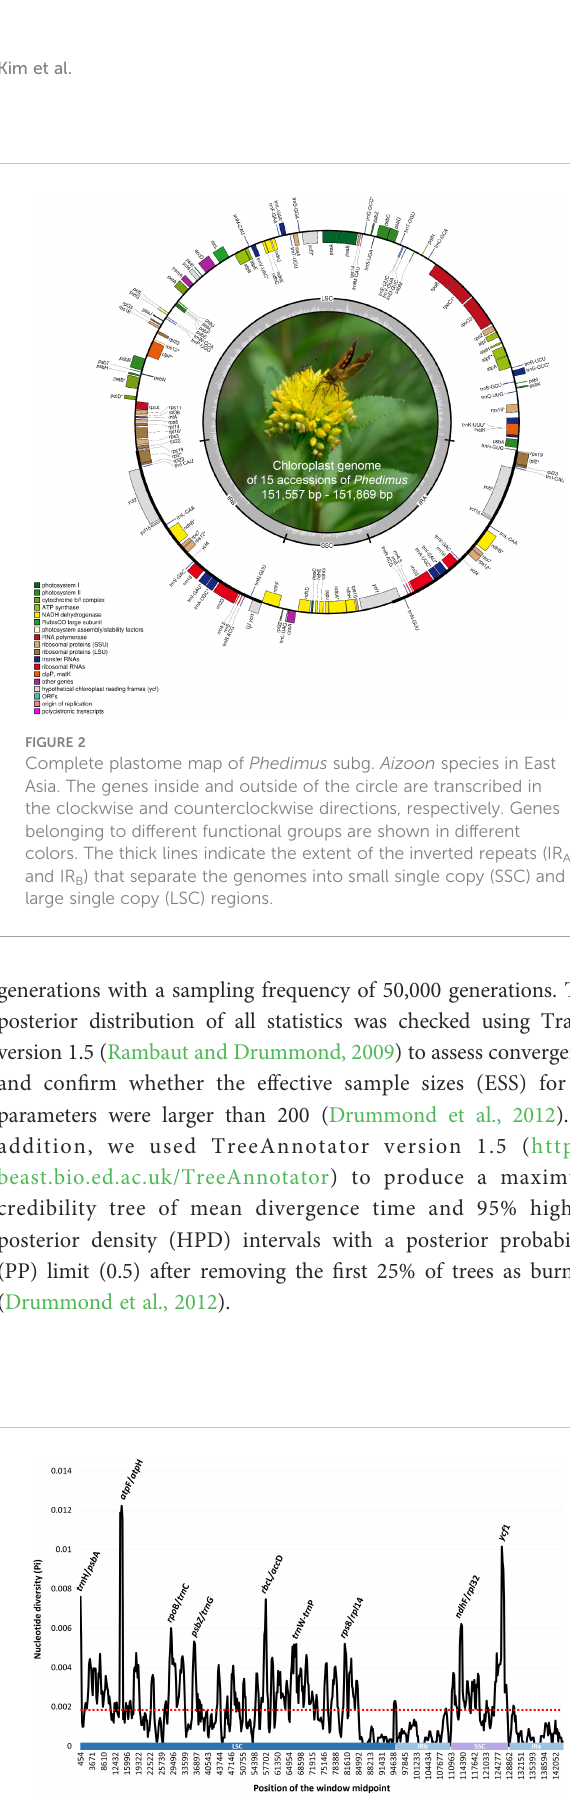
FIGURE 3 Sliding window analysis of the whole plastomes of 15 accessions (11 taxa) of Phedimus subg. Aizoon .